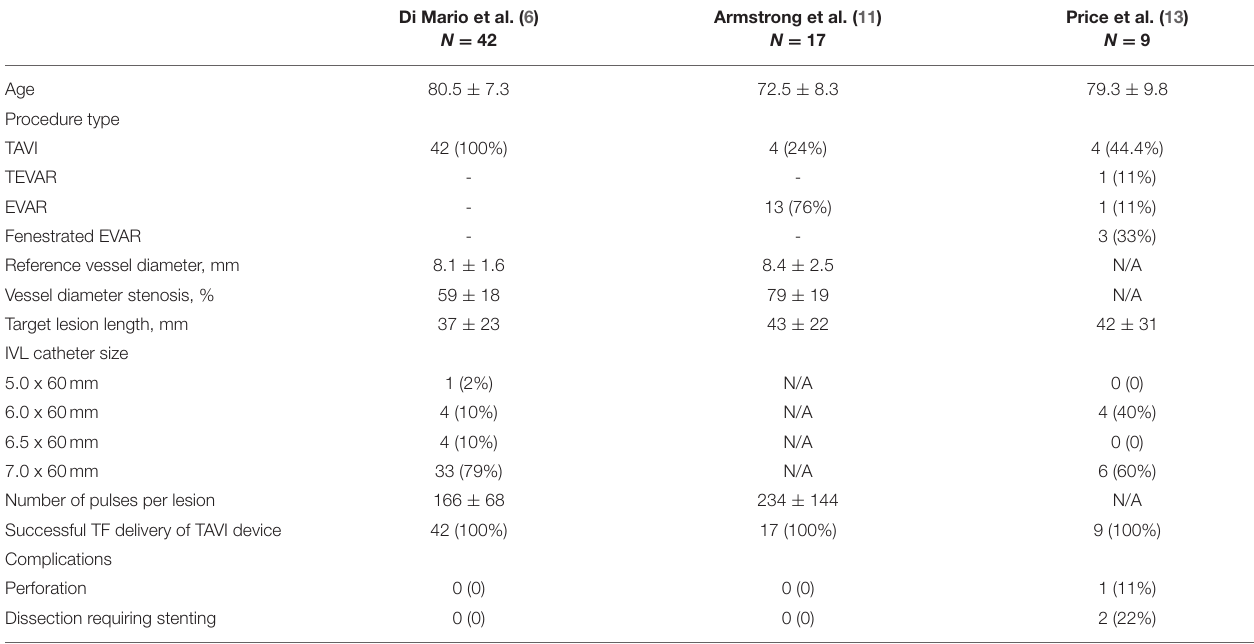
TABLE 2 | Summary of studies on IVL-assisted large-bore transfemoral